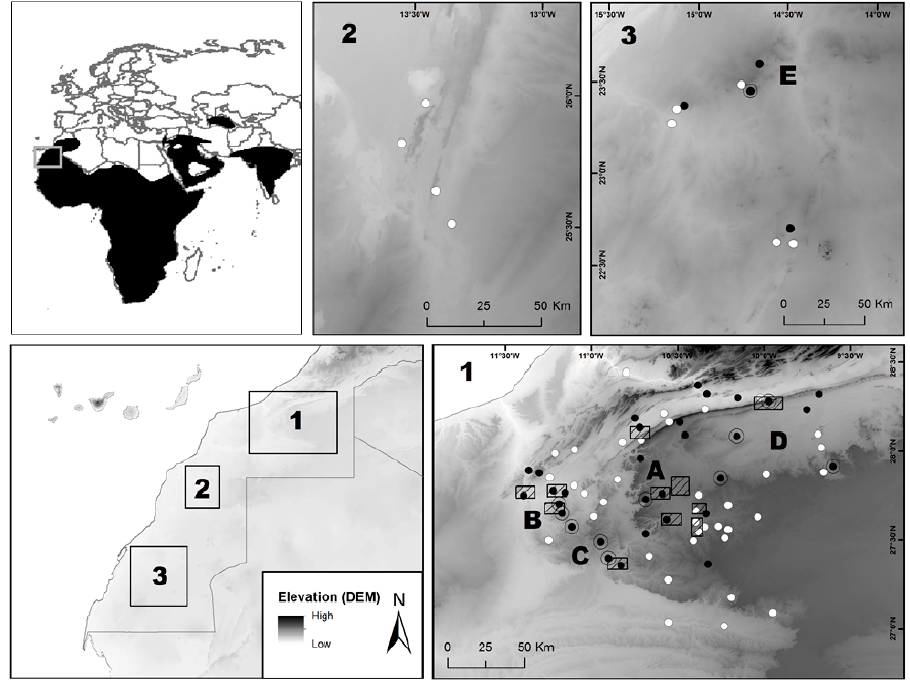
Figure 1. Study areas in the Atlantic Sahara (from 2013 ESRI, i-cube, GeoEye), honey badger global range [14] and distribution of the walking survey plots: Black points are sites where honey badgers were detected (feces, footprints, camera trap records and sightings) and white points are negative surveys; encircled black points show where the honey badger feces were collected: A) Red Aydar, B) Black Aydar N, C) Black Aydar SE, D) Tigsert Basin, E) Negjyr. Rectangles show the camera trapping sites.